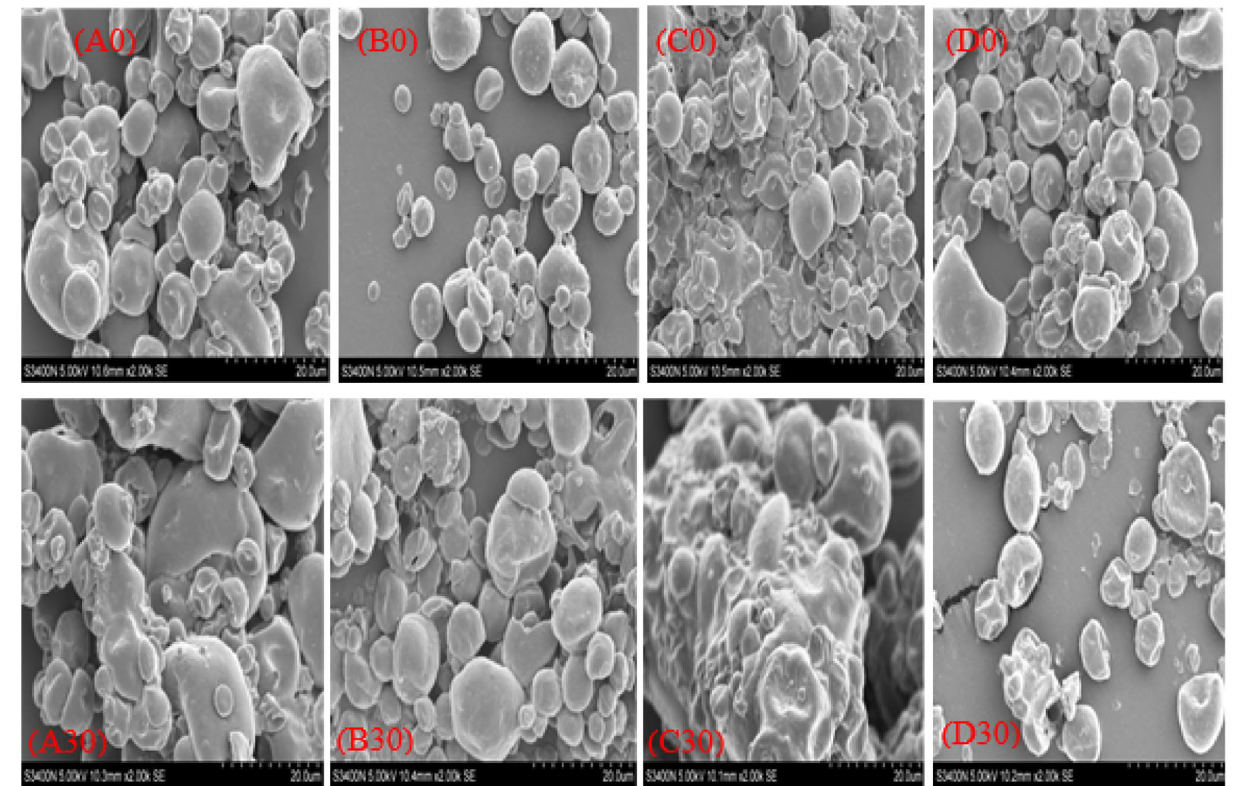
Figure 3. Scanned electron microscope images of yak butter powders sample A to D at day zero (represented by A0, B0, C0, and D0) and after 30 days storage at 65 °C (represented with A30, B30, C0, and D30) using 2000SE